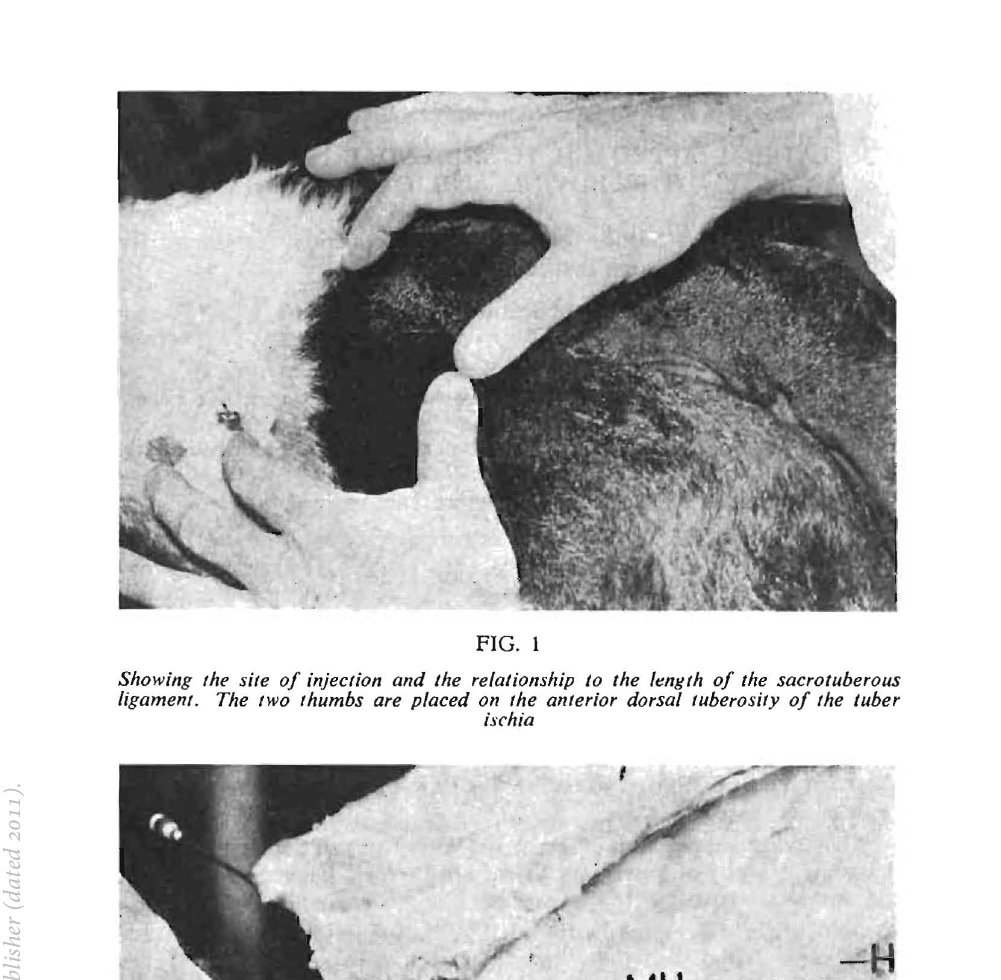
Showing {he si{e of injec{ion and the relationship to the lt1ng{h of the sacrotuberous Iigamenl. The {WO {humbs are placed on {he an{erior dorsal {uberosily of {he tuber ischia